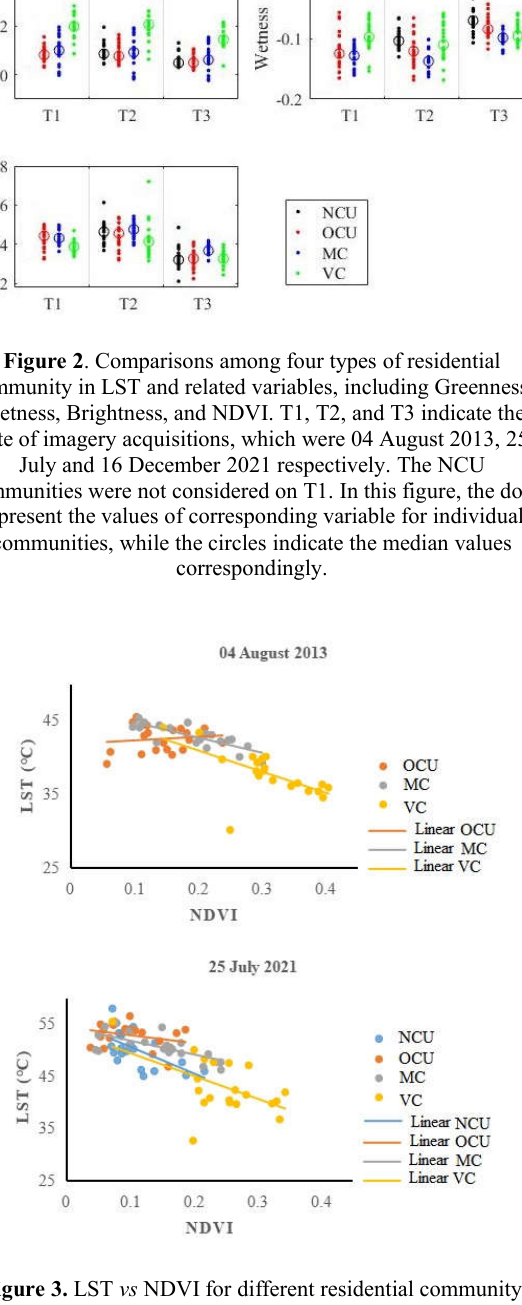
Figure 3. LST vs NDVI for different residential community types as recorded by two specific observations of the Landsat-8 OLI/TIRS, acquired on 04 August 2013 and 25 July 2021 respectively. The NCU communities were not considered in analyzing the data acquired on 04 August